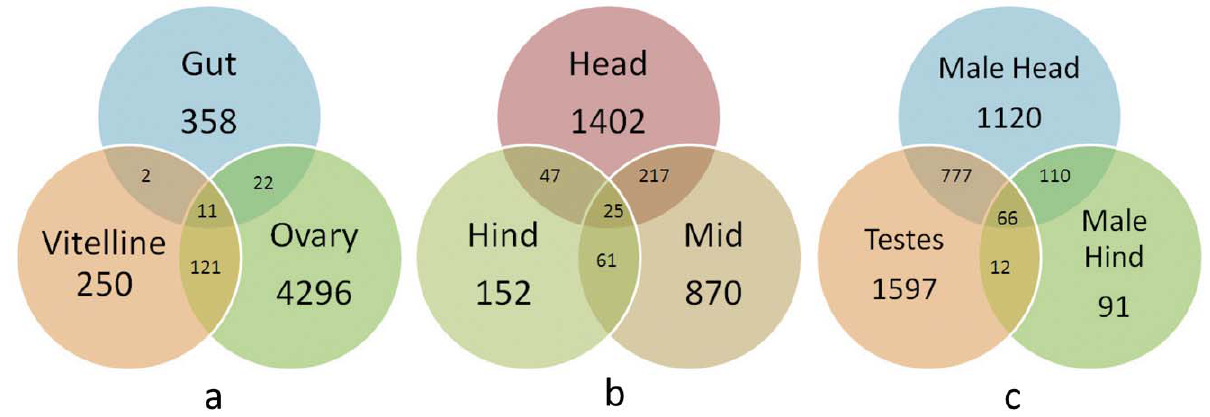
Figure 2. Genes enriched in specific tissues of adult S.mansoni . Venn diagram showing the numbers of S. mansoni genes up-regulated at least 2-fold in (a) microdissected female tissues, (b) macrodissected female tissues, (c) macro-dissected male tissue and testes.